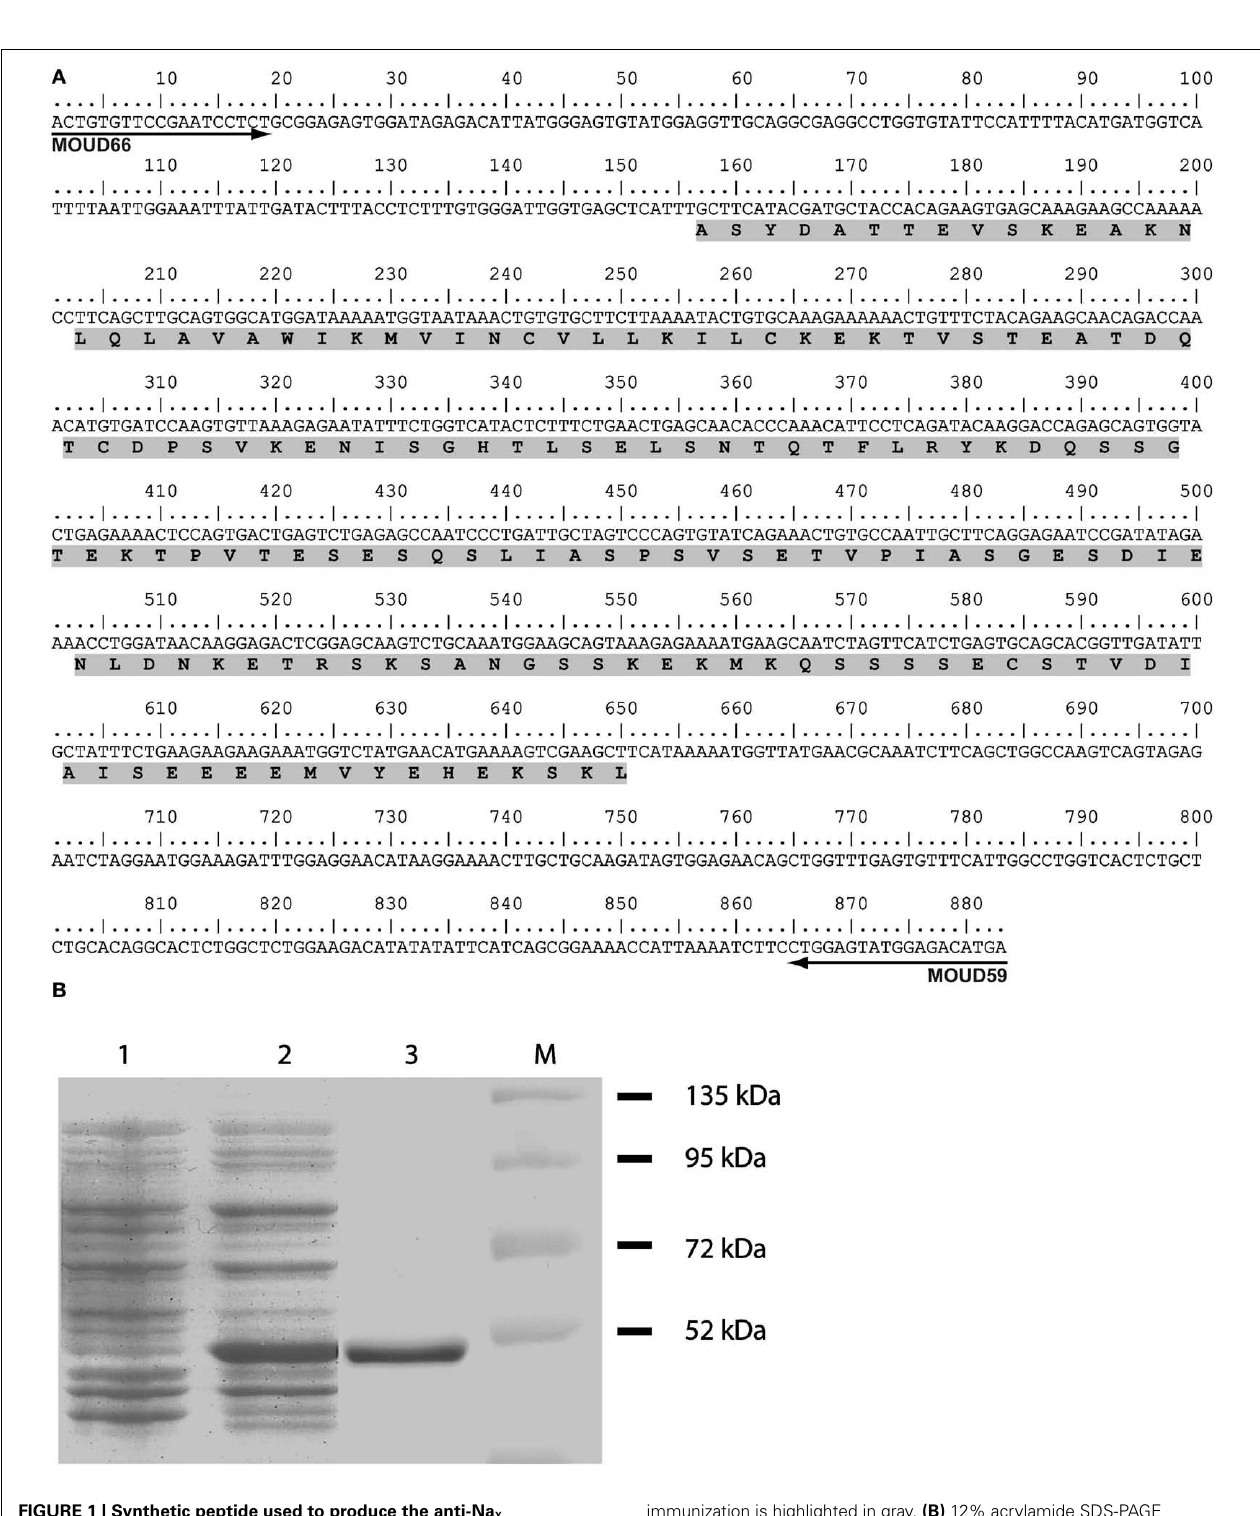
FIGURE 1 | Synthetic peptide used to produce the anti-Na X antibody. (A) Representation of the partial nucleotide sequence of the Na X -ID 2–3 .The nucleotide sequence corresponds to the nucleic acid targeted for RT-PCR experiment carried out with the primers MOU66 and MOU59.The sequence of the synthetic peptide used for the rabbit